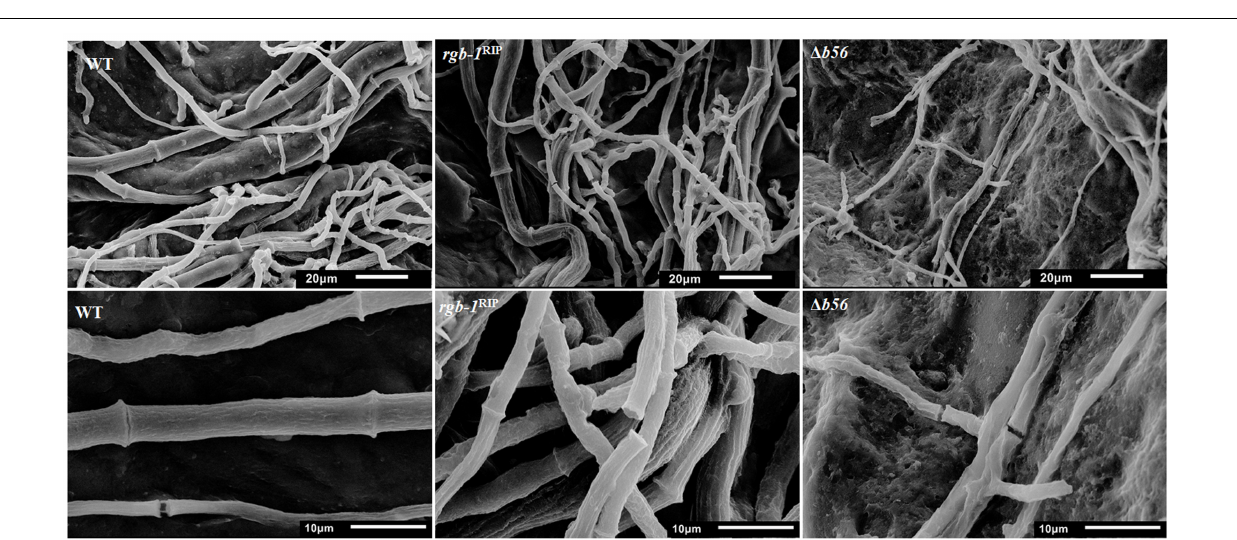
FIGURE 4 | Inactivation of PP2A regulatory subunits impairs hyphal morphology. Scanning electron micrographs of wt, rgb-1 RIP , and (cid:49) b56 hyphae from strains cultured on VgS medium. Upper panel bar = 20 µ m, lower panel bar = 10 µ